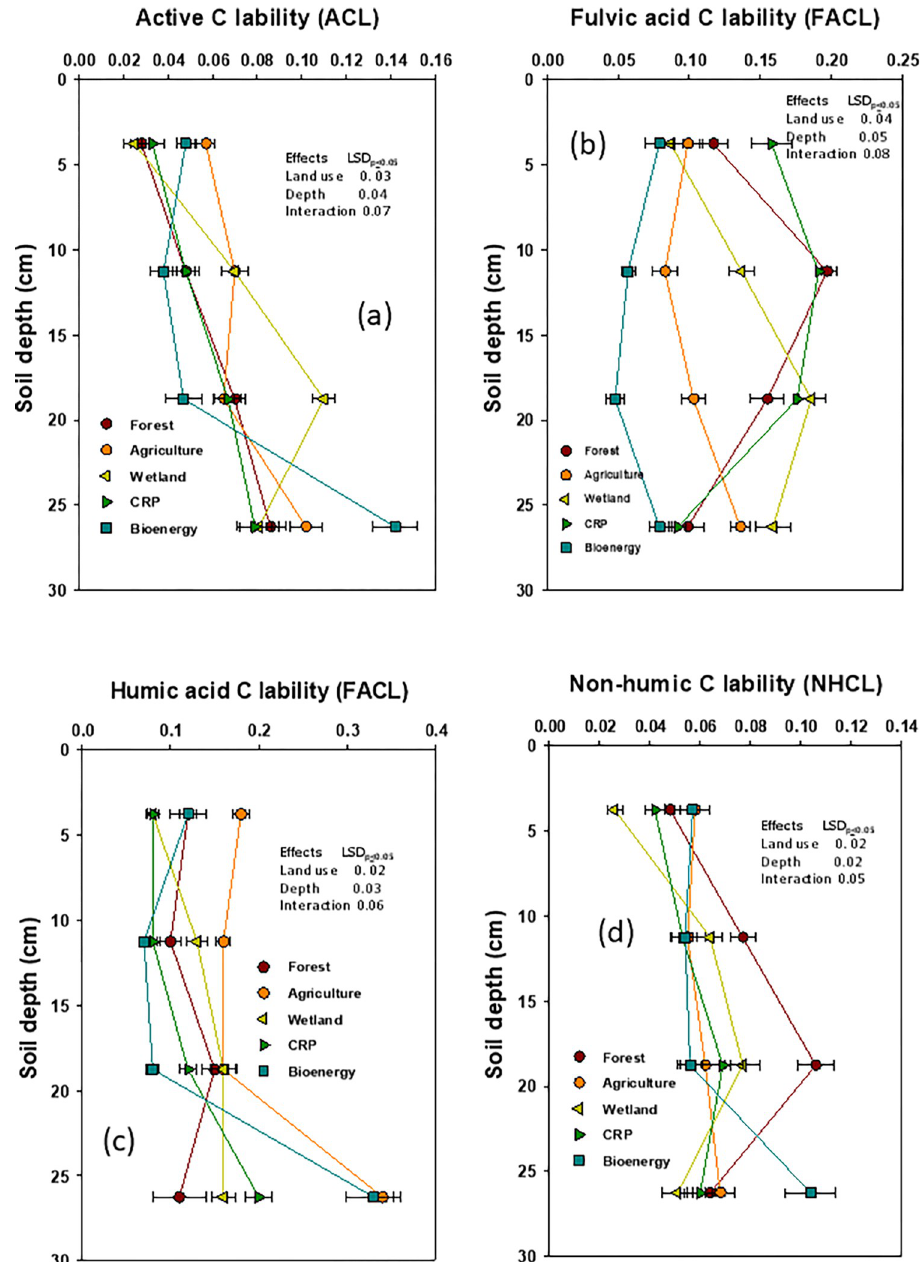
Fig 5. Impact of deforestation and subsequent land-use diversity on active carbon (AC), fulvic acid (FA), humic acid (HA), and glucose equivalent total non-humic carbon (NH) lability at different soil depths (data were presented with mean ± standard